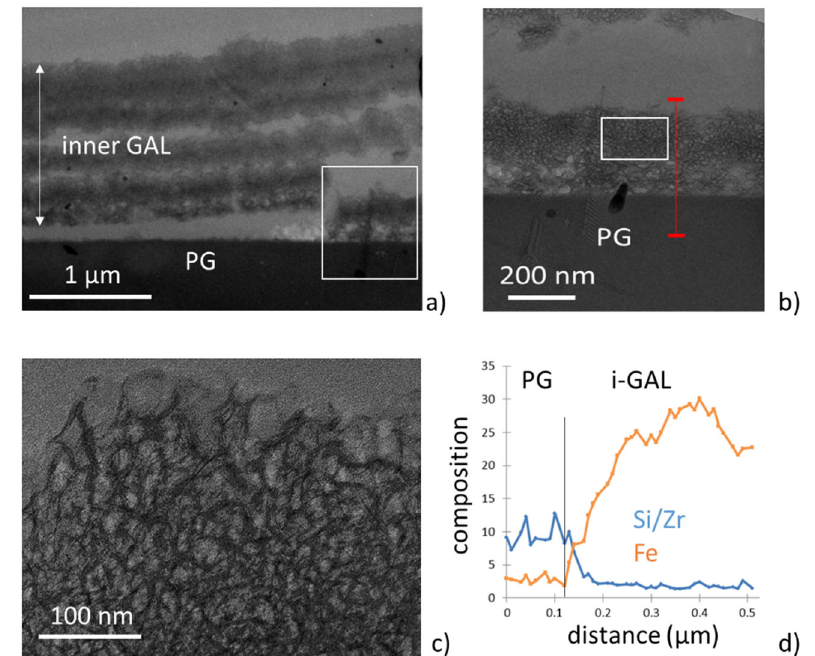
Fig. 3 TEM analyses performed in the inner GAL. a TEM micrographs of the i-GAL evidencing several strata and location of the pro fi le composition (red line) in the fi rst stratum ( b ). In c , HRTEM in the fi rst stratum of the i-GAL showing foliated aggregates compatible with the smectite morphology. In d , TEM-EDS pro fi le composition (wt.%) obtained in the fi rst stratum of the i-GAL highlighting the PG/i-GAL